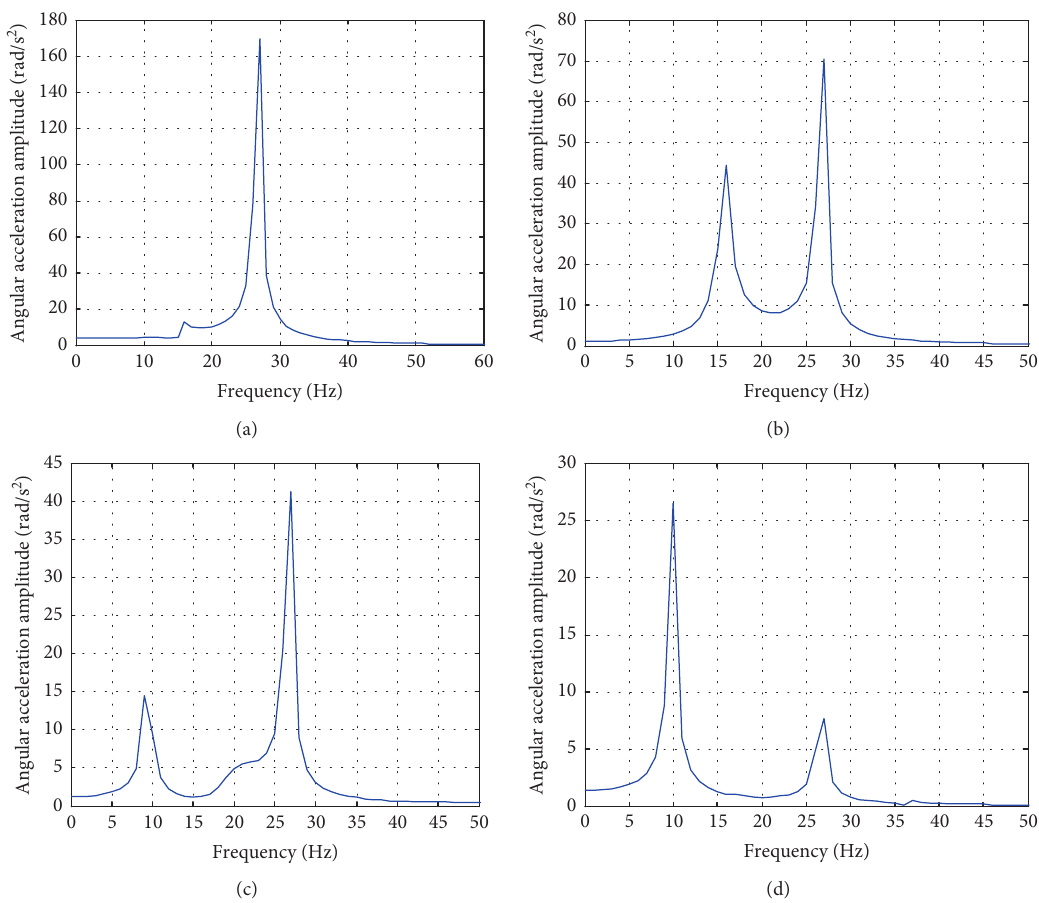
Figure 7: Spectra of J 8 and J 10 under the idling condition. (a) spectrum of J 8 and (b) spectrum of J 10 of DMF; (c) spectrum of J 10 of DMF with simple CPVA; (d) spectrum of J 10 of DMF with bifilar